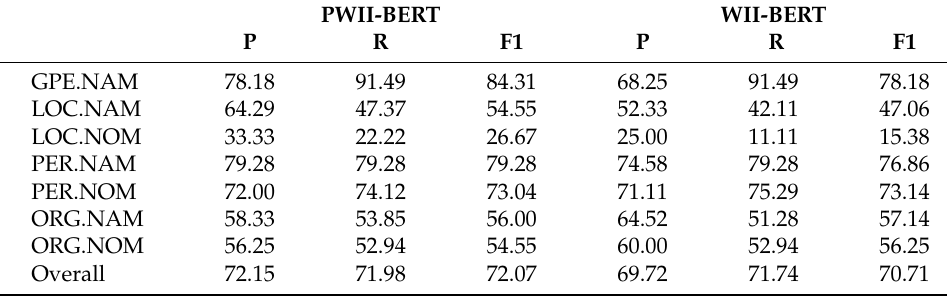
Table 6. Results of P, R, and F1 score on the Weibo